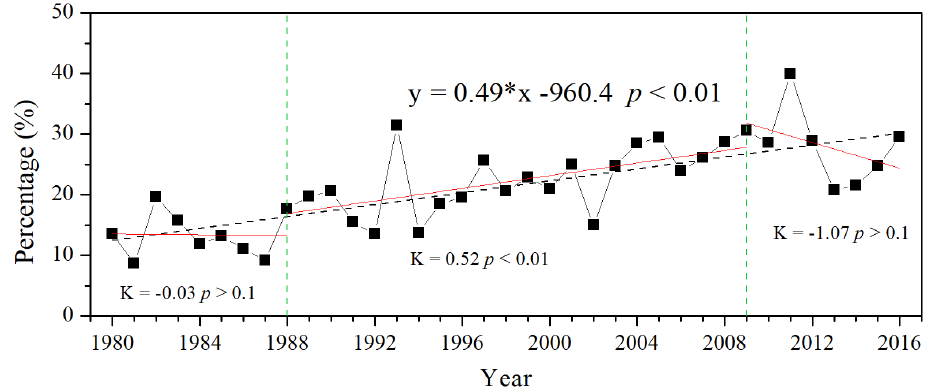
Figure 12. Variations of annual fraction of snow and glacier melt in total lake inflow from 1980 to 2016. The black dotted line (linear fitting in the whole period), red lines (linear fitting for each period) and the green dotted line (period dividing) are given for reference.